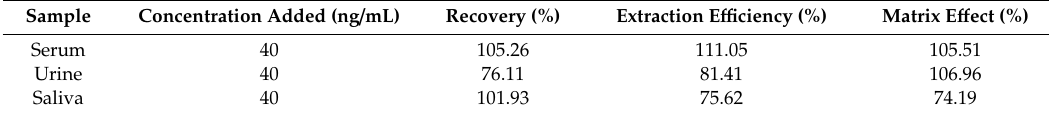
Table 3. Recovery, extraction e ffi ciency and matrix e ff ect obtained for